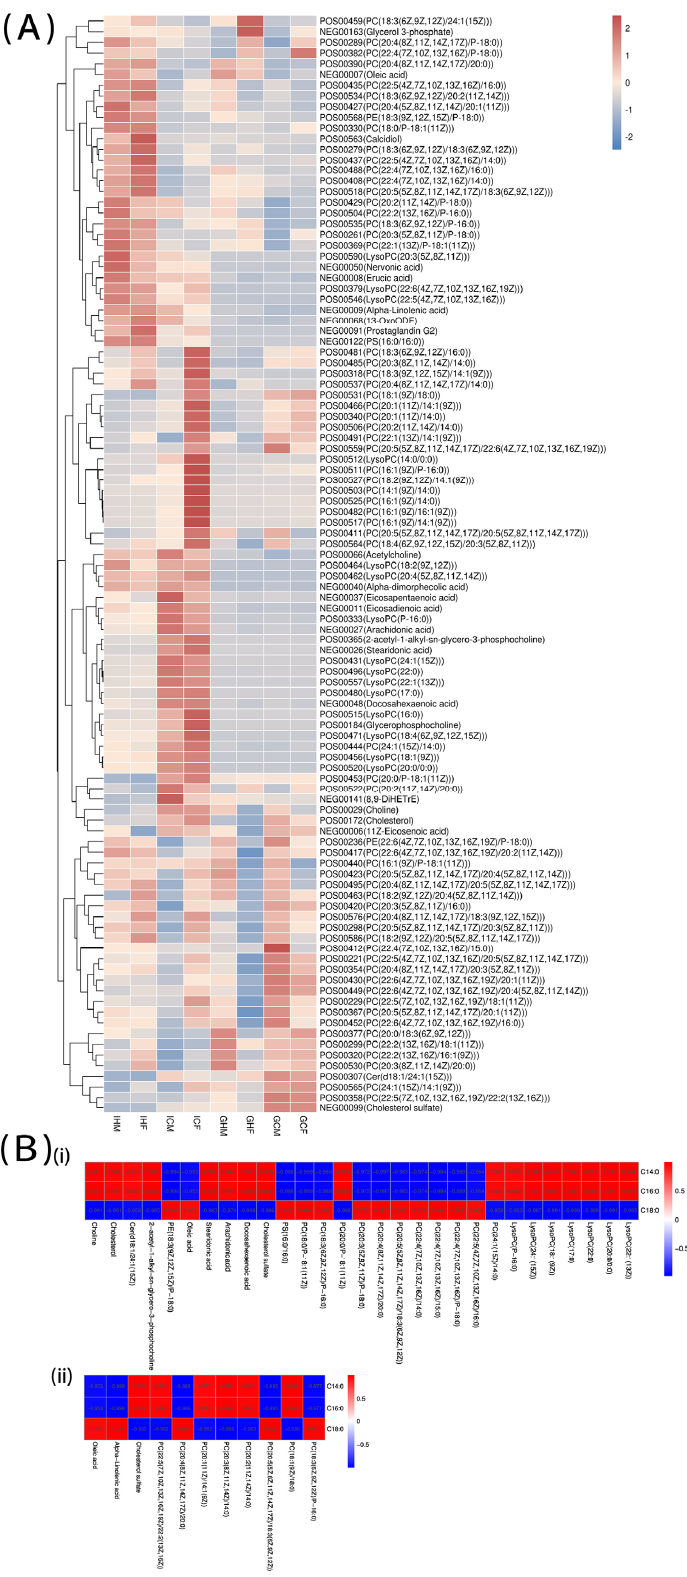
Figure 4. Intestinal and gonadal metabolites related to lipid metabolism pathways in sea cucumbers and their correlation with fatty acids in experimental diets. ( A ) Heatmap of metabolites related to lipid metabolism pathways. ( B ) Lipid metabolites significantly associated with fatty acids in experimental diets [(i): intestines; (ii):